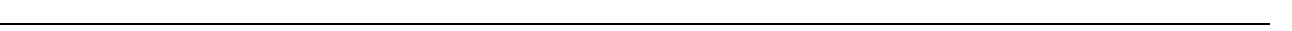
Fig. 3 Resected forks are able to restart in BRCA2-de fi cient cells and lead to increased chromosomal aberrations. a Expression of RAD51 after siRNA knockdown in U2OS cells. b Size distribution of IdU tract length in BRCA2-de fi cient and -pro fi cient U2OS cells in the presence and absence of HU. Cells were transfected with control siRNA (siNEG), RAD51 siRNA, or BRCA2 siRNA before IdU and CldU labeling. Out of 2 repeats; n ≥ 250 tracts scored for each data set. Bars represent the median. Statistics: Mann – Whitney; **** P < 0.0001. c Schematic of the single-molecule DNA fi ber tract analysis for the fork restart experiments. Red-green contiguous tracts (restarting forks). Red only tracts (stalled/terminated forks). d Quanti fi cation of restarting forks in BRCA2-de fi cient and -pro fi cient U2OS cells with or without RAD51 siRNA knockdown. Out of 2 repeats, the percentage is established on at least 250 tracts scored for each data set. Mean shown. Errors, S.E.M. Statistics: unpaired t test; ** P < 0.01. e Quanti fi cation of restarting forks in BRCA2-de fi cient and -pro fi cient U2OS cells with or without EXO1 siRNA knockdown. Mirin (50 μ M) was added concomitantly with HU treatment, as indicated. Out of 2 repeats, the percentage is established on at least 250 tracts scored for each data set. Mean shown. Errors, S.E.M. f Size distribution of CldU tract length in BRCA2- de fi cient and -pro fi cient U2OS cells in the presence of HU. Cells were transfected with control siRNA (siNEG), EXO1 siRNA, or BRCA2 siRNA before IdU and CldU labeling. Mirin (50 μ M) was added concomitantly with HU treatment, as indicated. Out of 2 repeats; n ≥ 250 tracts scored for each data set. Bars represent the median. Statistics: Mann – Whitney; **** P < 0.0001. g Chromosomal aberrations in BRCA2-de fi cient and -pro fi cient U2OS cells in the presence of HU. Left, representative images of metaphase spreads in the presence of HU. Scale bar, 25 μ m. Sketch above the images delineates experimental design. Right, numbers of chromosomal aberrations per metaphase are plotted. At least 50 metaphases counted in each experiments. Mean shown, n = 3.. Errors, S.E.M. Statistics: unpaired t test: **** P <